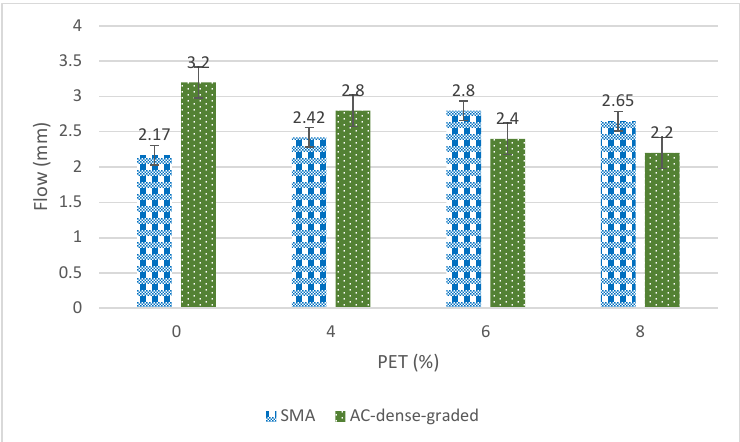
Figure 10. Effect of PET on the stability of modified asphalt mixtures.